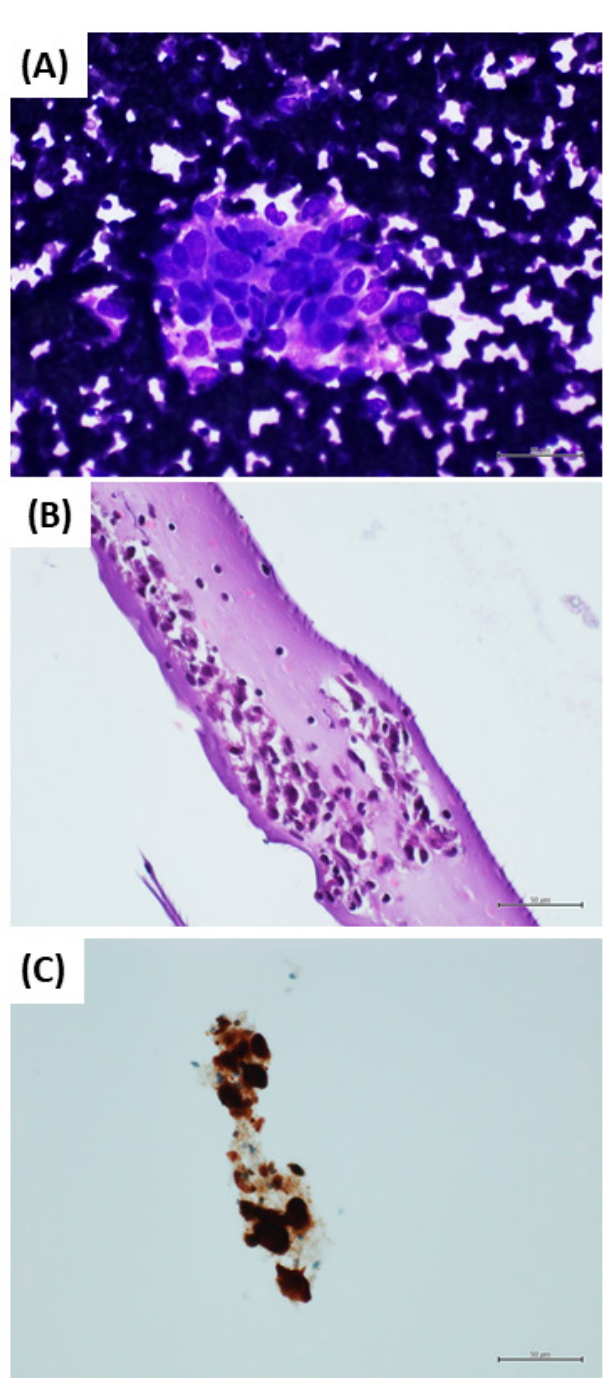
Figure 3. Inguinal lymph node fine-needle aspiration cytology: ( A ) direct smear: cell aggregate consisting of medium–large-sized cells with irregular nuclear membrane and large eosinophilic cytoplasm. In this context, only a few small lymphocytes are recognized. Morphologically, these aspects are not clearly identifiable with a macrophage–lymphocyte complex (May Grunwald Giemsa stain, 400×). ( B ) Cell block section: medium-sized cells with round–oval nuclei, sometimes incised and granular cytoplasm, eosinophilic. Small, mature lymphocytes are also present (hematoxylin and eosin stain, original magnification 400×). ( C ) S100 immunostaining in this cell aggregate is positive; PRAME and SOX10 are negative (S100 immunostain, original magnification 400×).